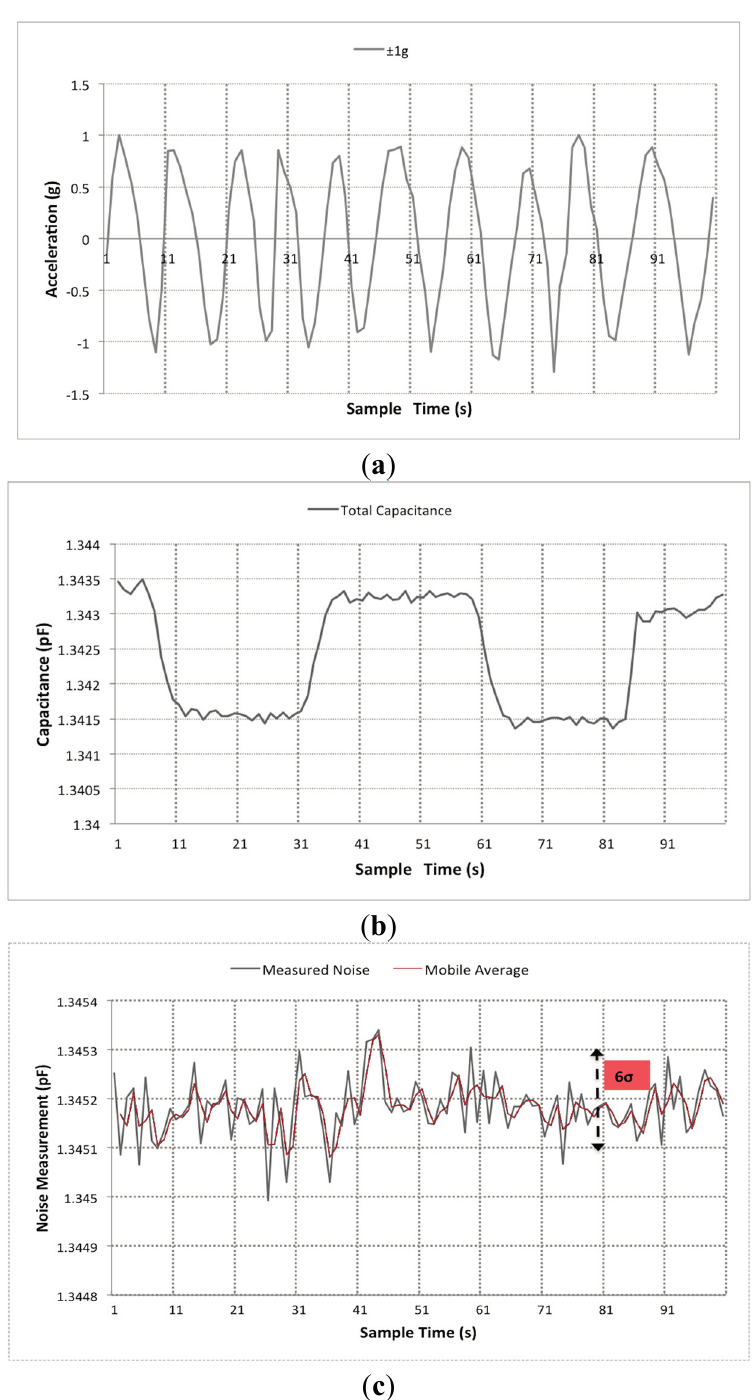
Figure 7. Experimental measurement results. ( a ) Response from ±1 g acceleration; ( b ) Capacitance measurement over ±1 g; ( c ) Generated noise from sensor